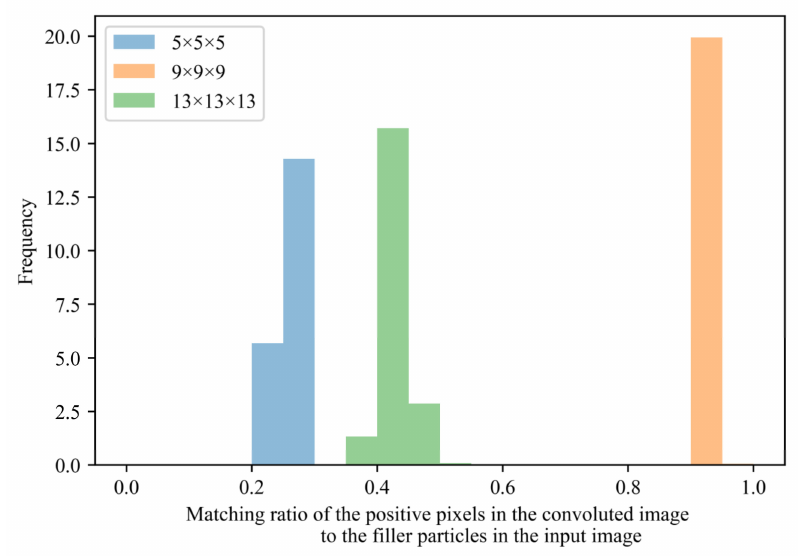
Figure 13. Ratio of the positive pixels in the convoluted image to the filler particles in the input image, which was defined as an A/B fraction. Here, A is the number of pixels with positive values in the convoluted image that overlap with the filler particles in the input image. B is the total number of pixels with positive values in the convoluted image. The blue, orange, and green colors correspond to the kernel sizes 5 × 5 × 5, 9 × 9 × 9, and 13 × 13 × 13,